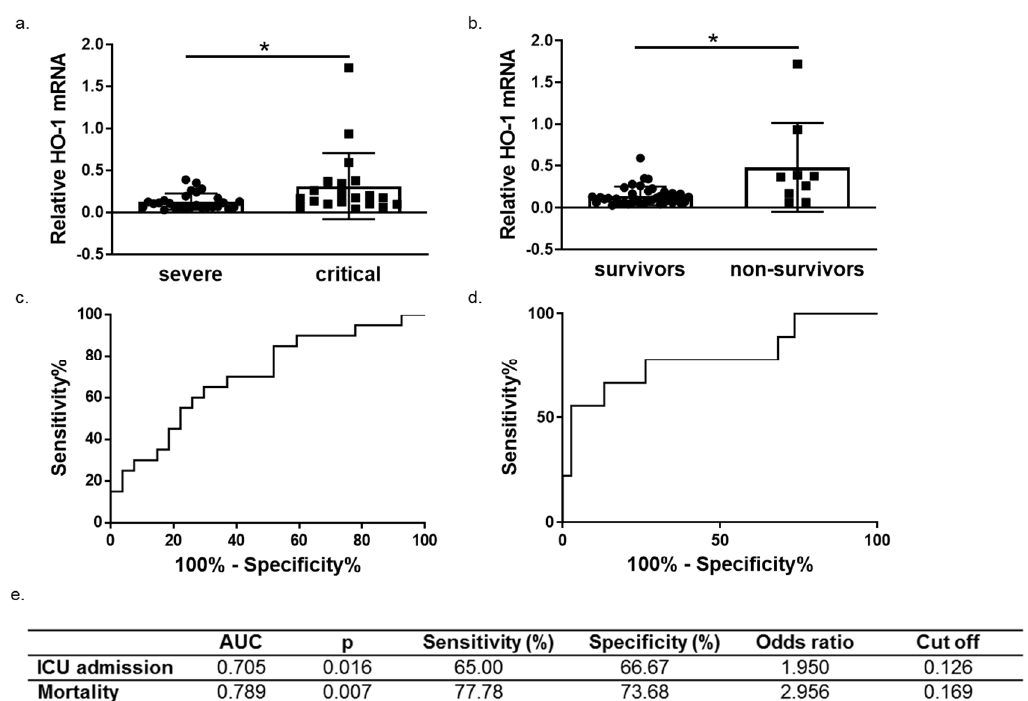
Figure 5. HO-1 mRNA levels are associated with COVID-19 progression and outcome. HO-1 mRNA upregulation in whole blood samples from ( a ) critical versus severe patients ( b ) survivors versus non-survivors. Receiver operating characteristic (ROC) curves of HO-1 mRNA levels for prediction of need for intensive care ( c ) and mortality ( d ). The corresponding areas under the curve (AUC), p, sensitivity and specificity, odd ratio and cut off values are represented in ( e ). Statistical analysis was performed by Mann–Whitney U test. * p < 0.05.